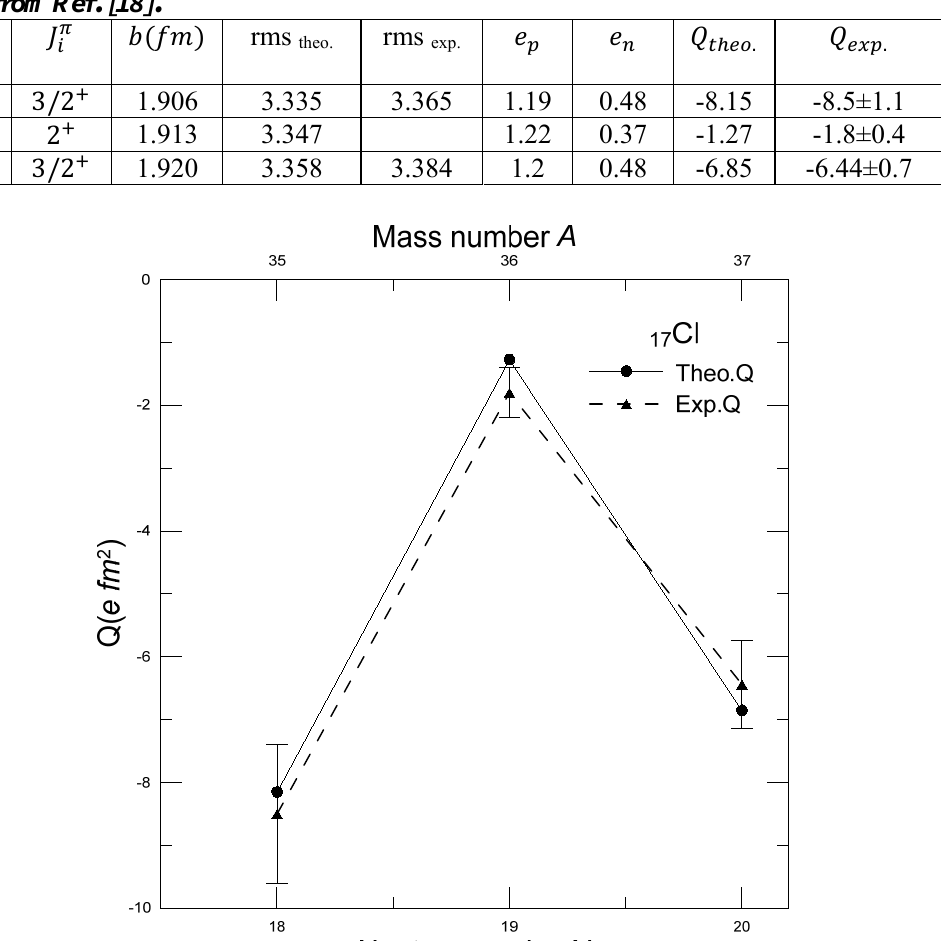
Fig. 5: Experimental [18] and theoretical quadrupole moments versus neutron number for Cl